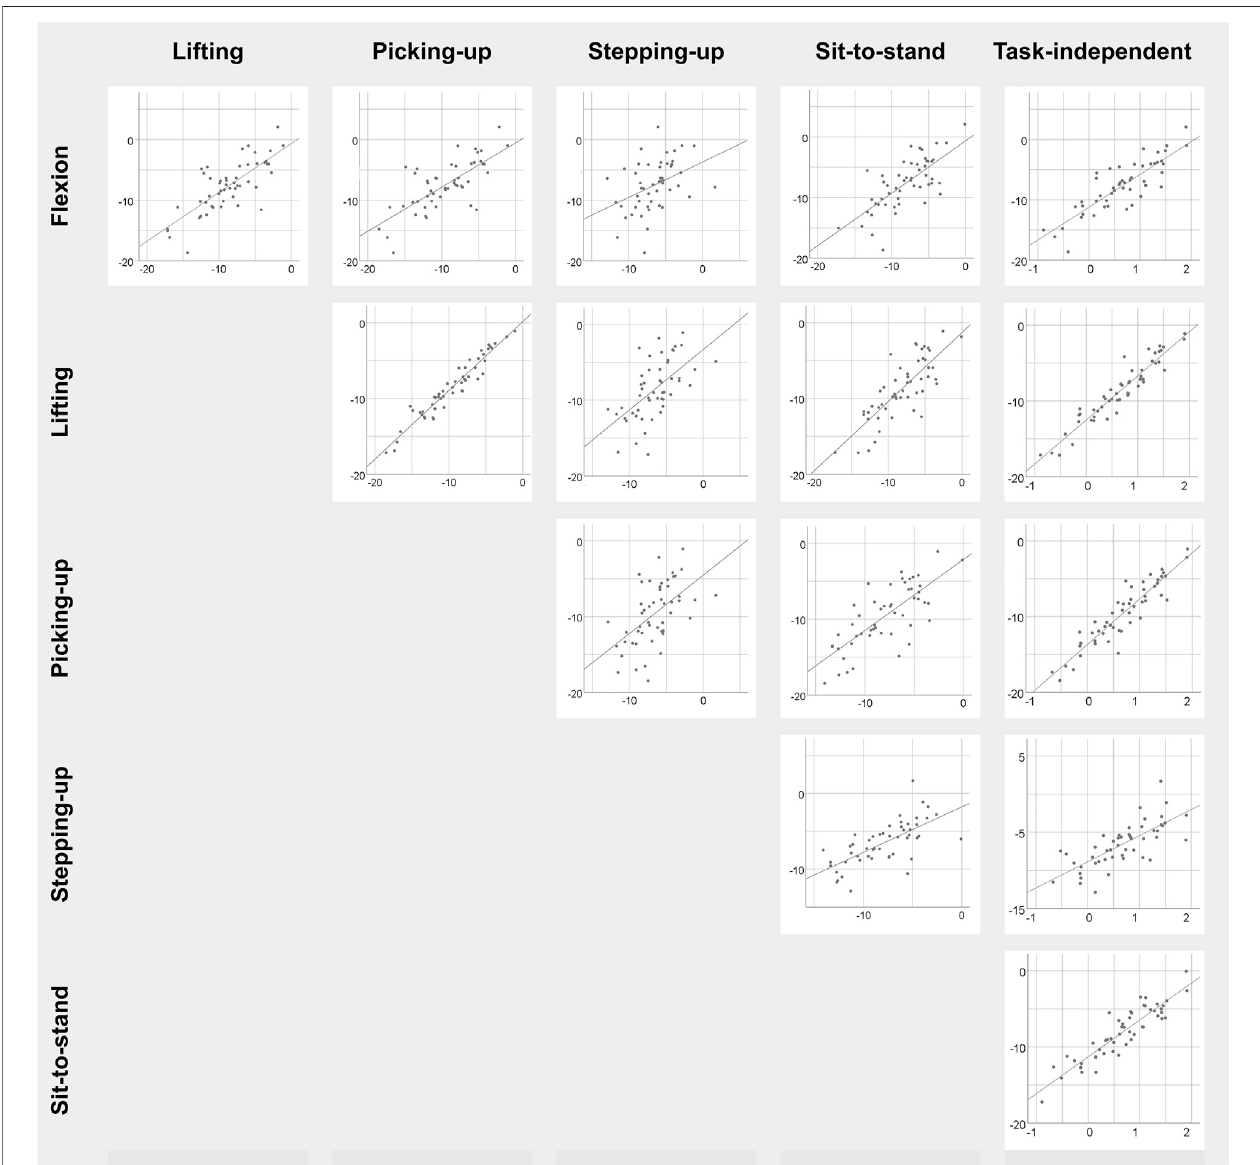
FIGURE 2 | Scatterplots of LLSa fl exion among the fi ve speci fi c functional tasks as well as with respect to the task-independent LLSa fl exion measure in patients with CLBP. Task-speci fi c measures are in degree and task-independent measures are dimensionless.